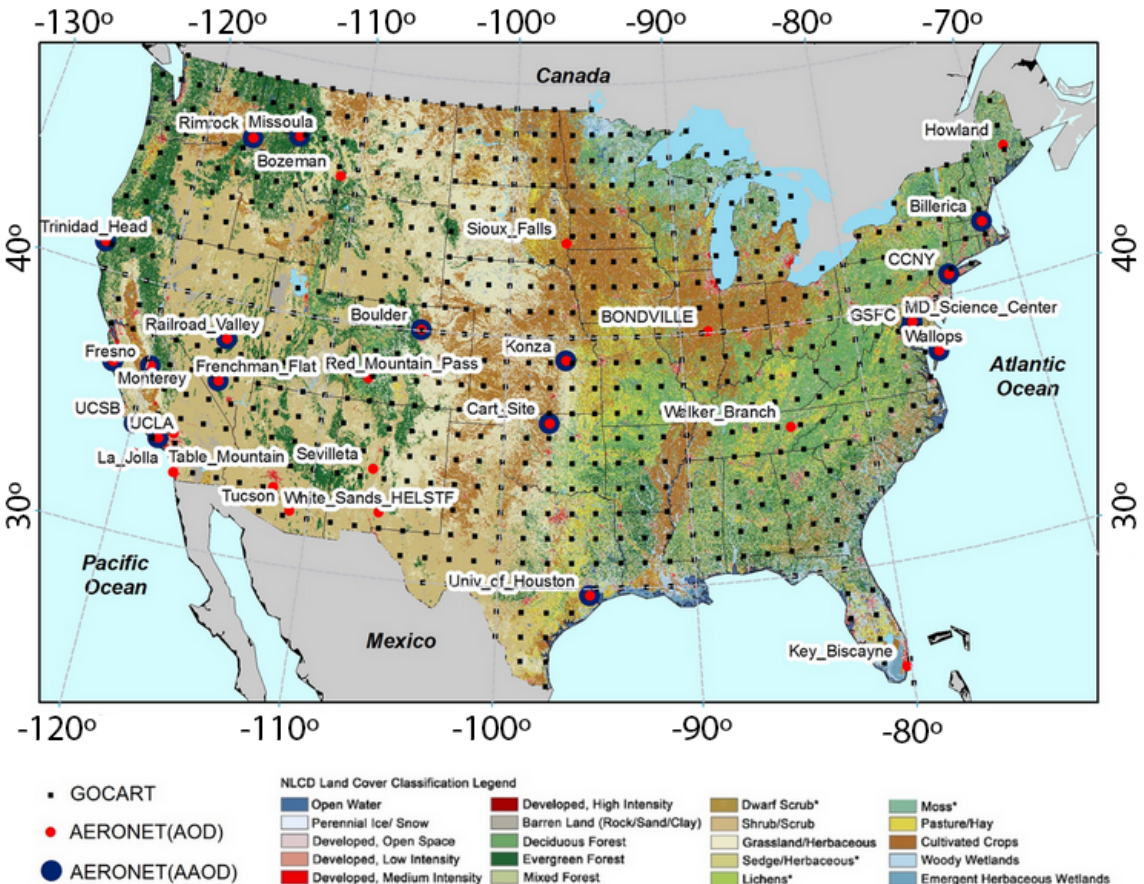
Figure 2. Spatial distribution of GOCART 1 ◦ × 1.25 ◦ grid points (blue dots), superposed on a map of the contiguous USA. Thirty-two AERONET sites containing AOD Level 2 data from 2006 to 2009 are shown as red dots; those also reporting SSA have a surrounding blue circle. The NLCD 2006 land cover layer, created by the Multi-Resolution Land Characteristics (MRLC) Consortium (http://www.mrlc.gov/ nlcd06_data.php), underlies the grid